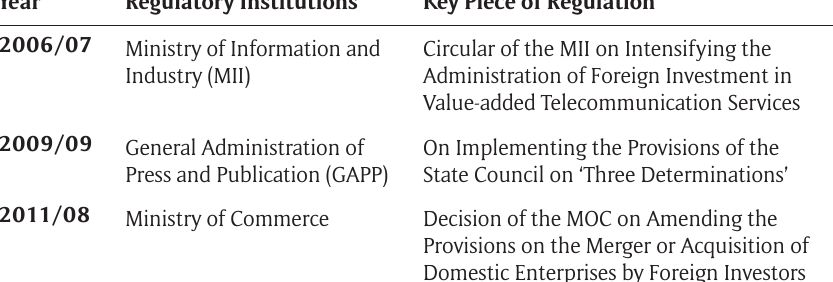
Table 3: Regulations of